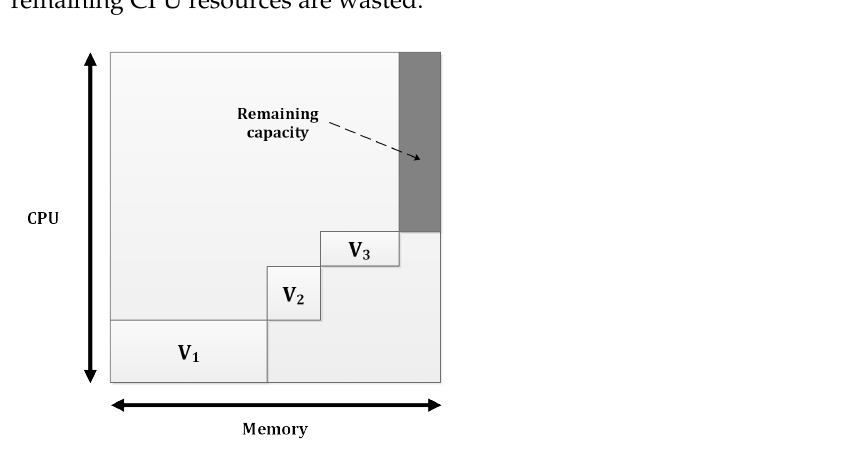
Figure 2. Example of resource allocation for 3 virtual machines deployed on a physical